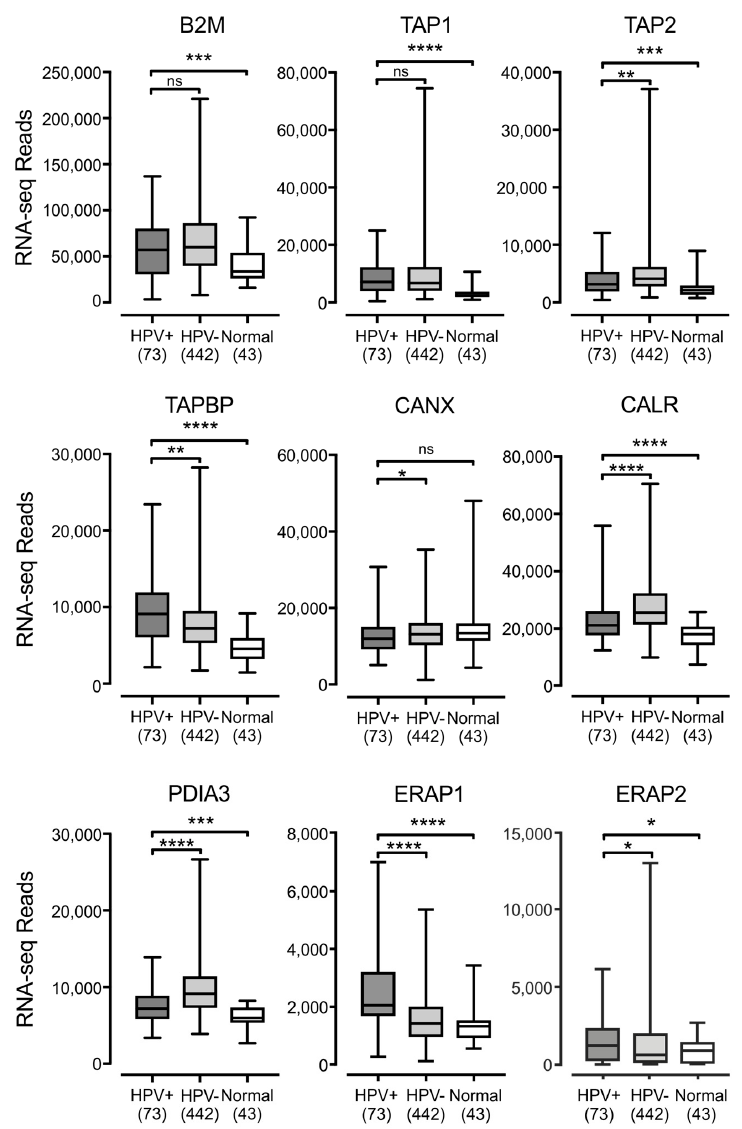
Figure 3. Expression of the MHC-I light chain and other genes involved in MHC-I dependent antigen presentation in head & neck carcinomas stratified by HPV status. Normalized RNA-seq data for the indicated genes involved in MHC-I dependent antigen presentation was extracted from the TCGA database for the HNSC cohort for HPV+, HPV − , and normal control tissues. Numbers in brackets refer to the number of samples included in each analysis. * p ≤ 0.05; ** p ≤ 0.01; *** p ≤ 0.001; **** p ≤ 0.0001; ns—not